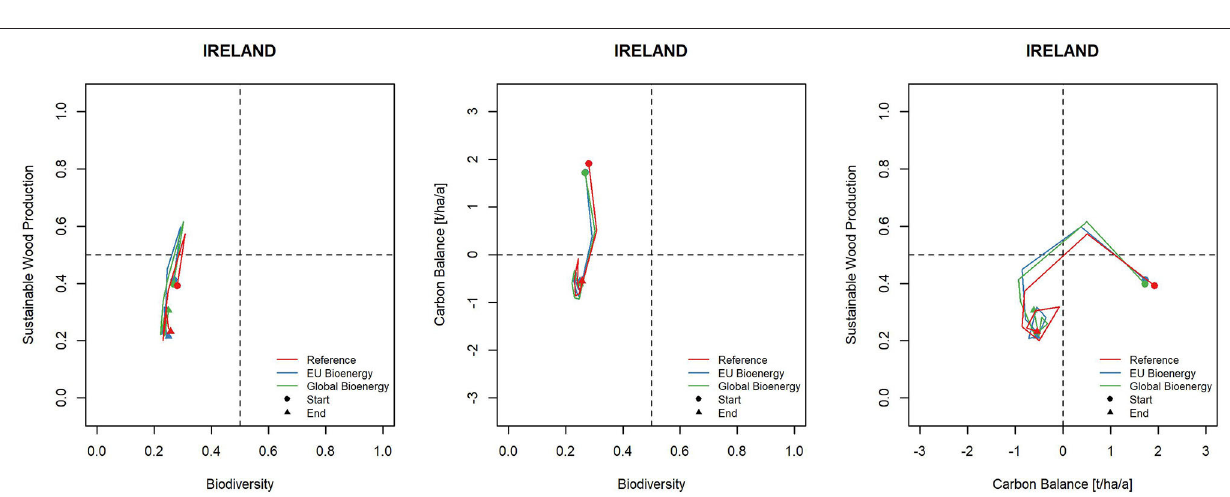
FIGURE 3 | Trade-off diagrams for Lithuania. The forest management scenarios “adaptive rotation ages” and “care for deciduous” are labeled in the left diagram.